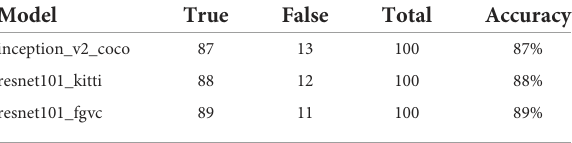
TABLE 5 The accuracy rate of different